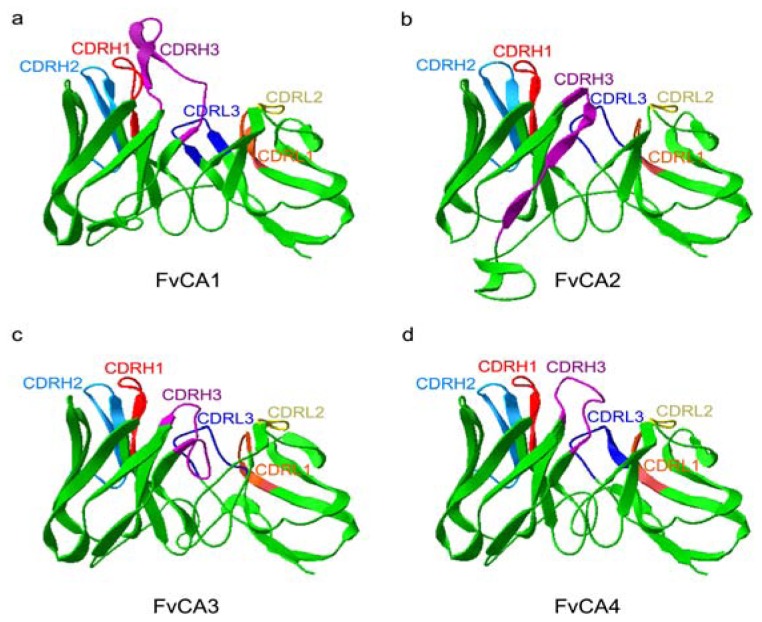
Three-dimension structure modeling of four selected scFv antibodies performed using DeepView. The scFv frameworks and linkers are indicated with green color. The VH and VL domains are shown with their names attached to different colors.